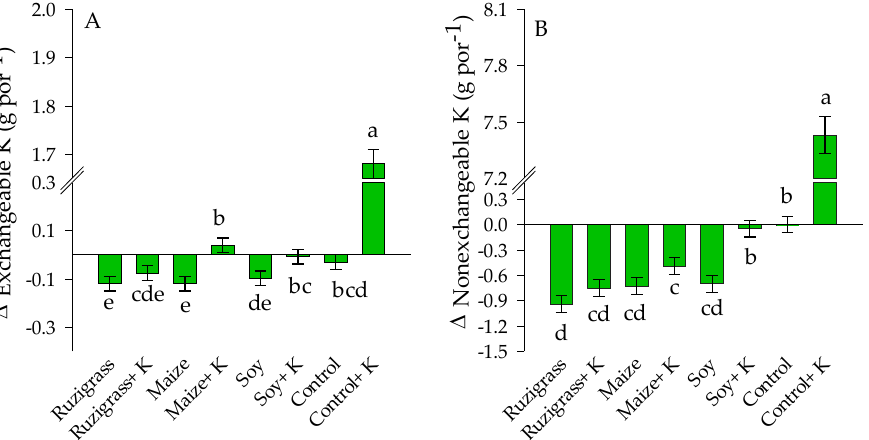
Figure 3. Net changes in soil-test, exchangeable K, ∆ Ke ( A ) and soil-test, non-exchangeable K, ∆ Kne ( B ) contents from before the first crop growth cycle to after the third crop growth cycle. The vertical bars represent standard error, and lowercase letters indicate difference among species (LSD, p ≤ 0.05). Exchangeable K was extractable by a Na-saturated exchange resin, and non-exchangeable K is the difference between K extracted by boiling 1 M HNO 3 and exchangeable K.